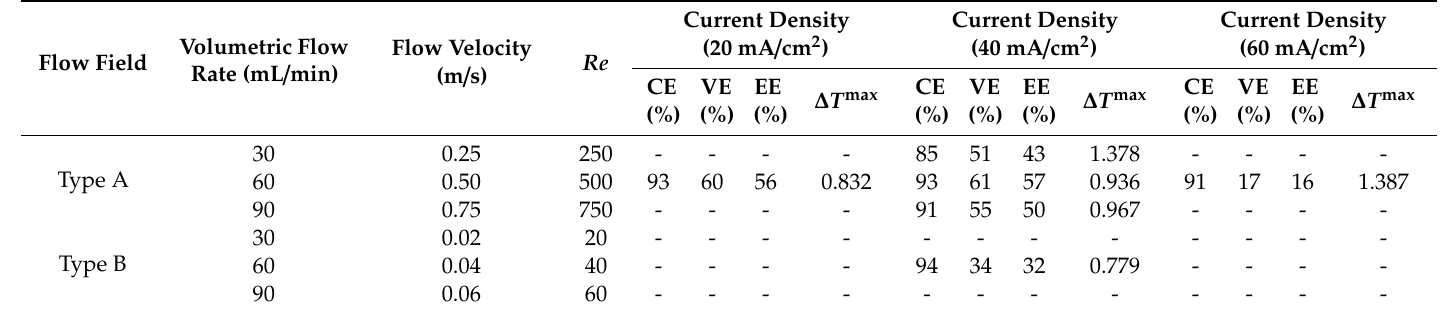
Table 4. The performance and thermal e ff ect of the V / I RFB with various charge-discharge parameters and flow fields for the charge-discharge test.